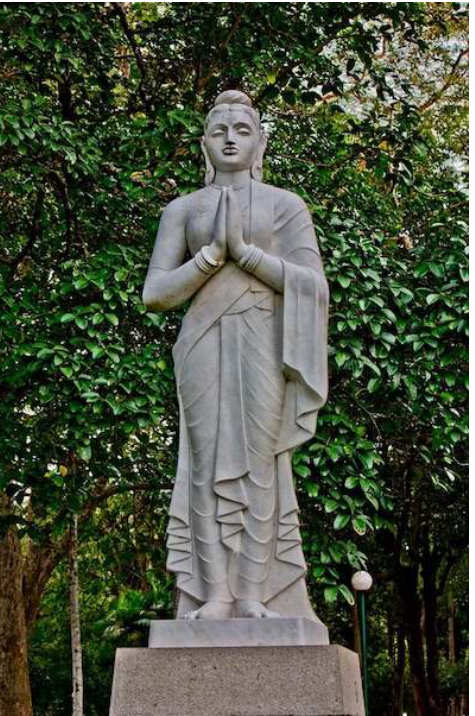
Figure 7. Representation of Viharamahadevi almost as a female Buddha in Colombo, Viharamahadevi